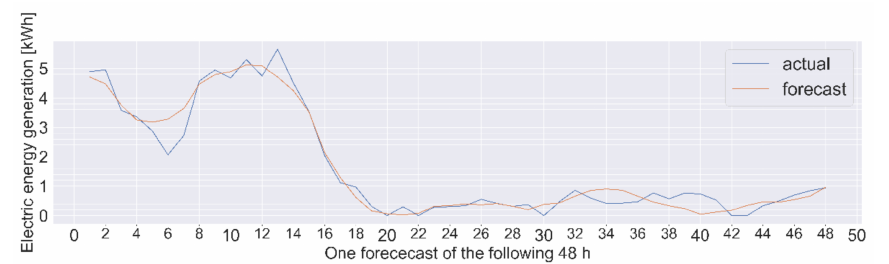
Figure 14. Forecast of electric energy generation from 1 to 48 h made by MLP_INT [PHM+LSTM, PHM+MLP PSO , PHM+KNNR] method for two following days of an autumn month (October).